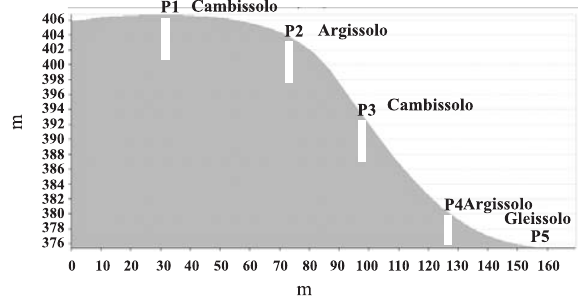
Figura 1. Perfil altimétrico da topossequência, abrangendo as formas plana, convexa, retilínea, côncava e plana, segundo a classificação de Troeh